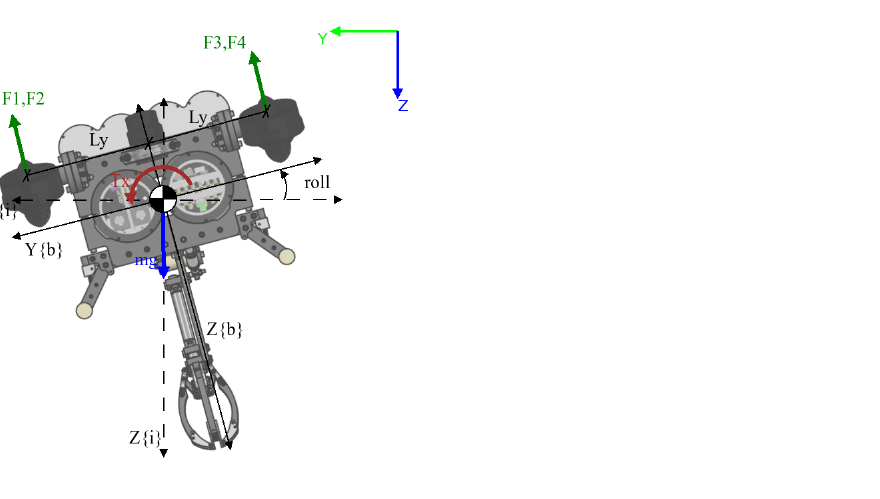
Figure 7. The applied forces visible on the Y–Z plane of the body-fixed frame.